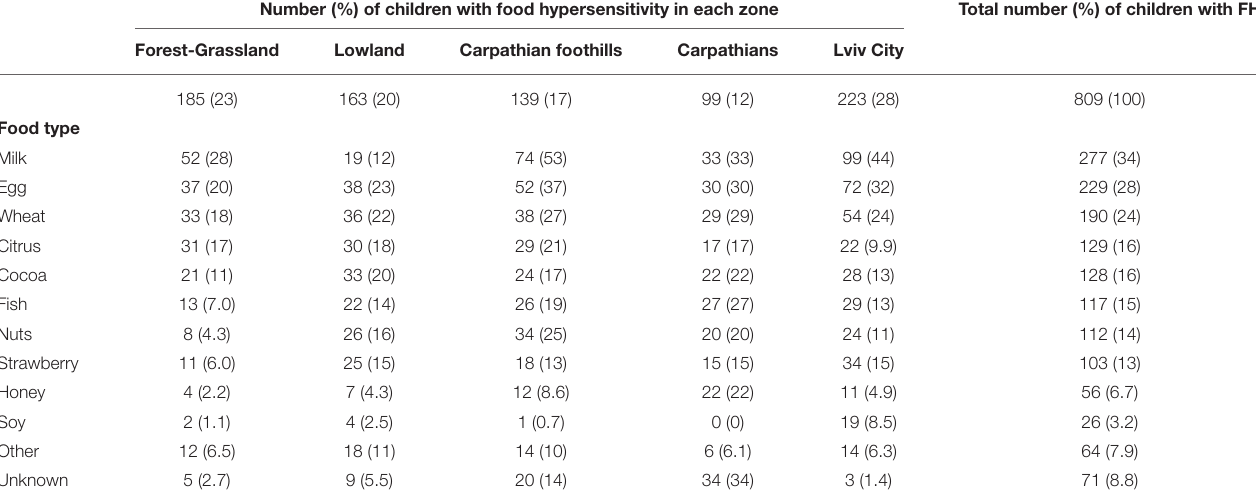
TABLE 3 | Distribution of children among geographic and climate zones according to hypersensitivity to food components. Group Number (%) of children with hypersensitivity to food components